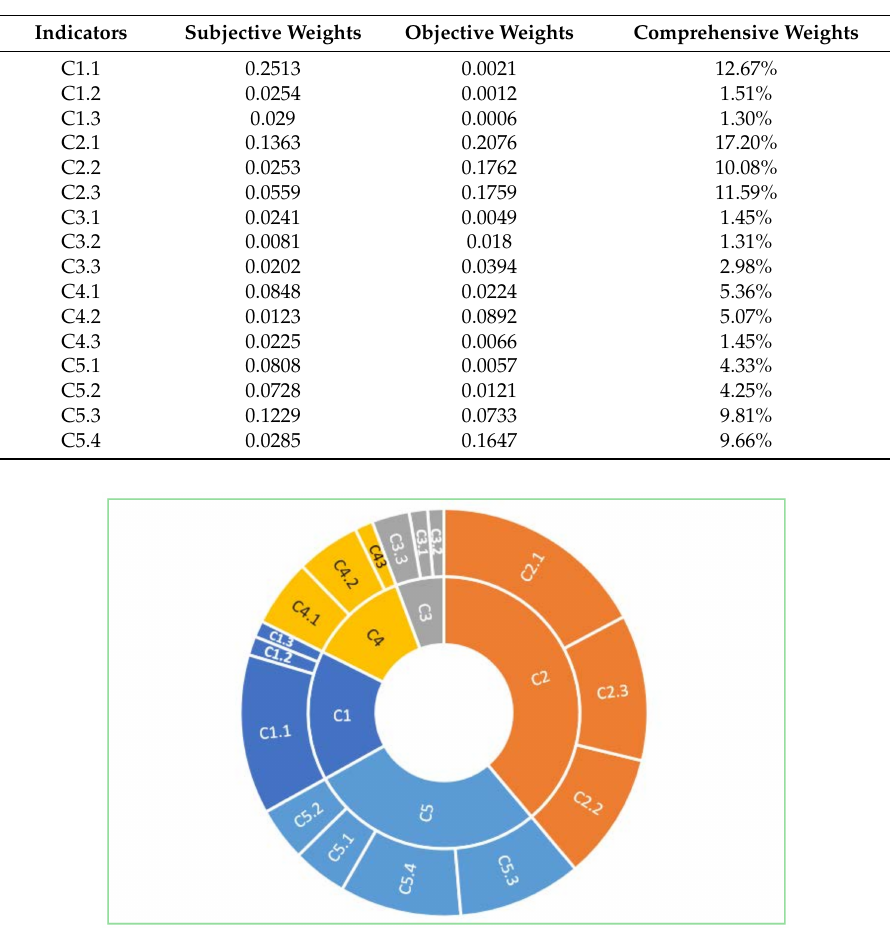
Table 5. Summary of the weight of each indicator.